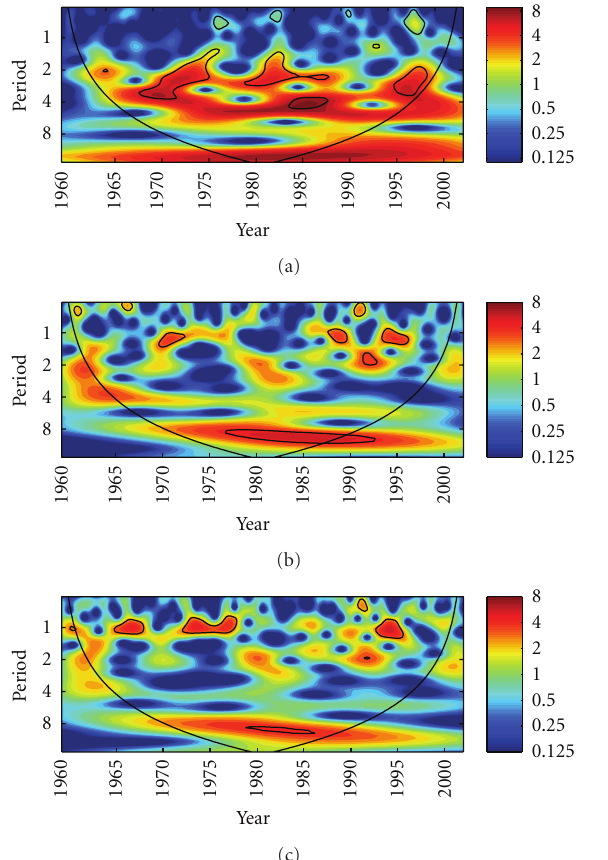
Figure 14: The wavelet autospectrum of SOI (a), water temperature at 0m (b), at 100 m (c). The 5% significance level against red noise is shown as a tick contour, and the thin black line indicates the cone of the influence.